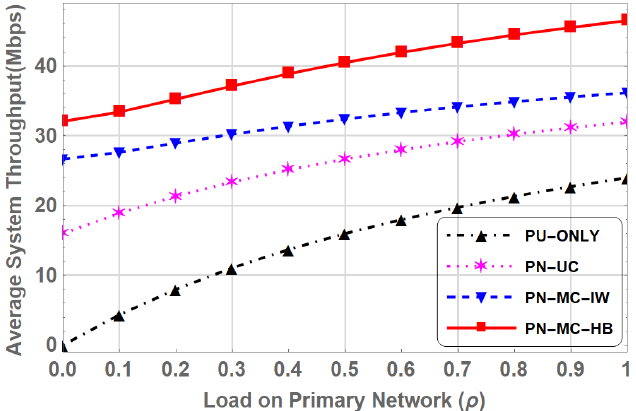
Figure 15. Comparison of Average System Throughput for PN-ONLY, PN-UC, PN-MC-IW and